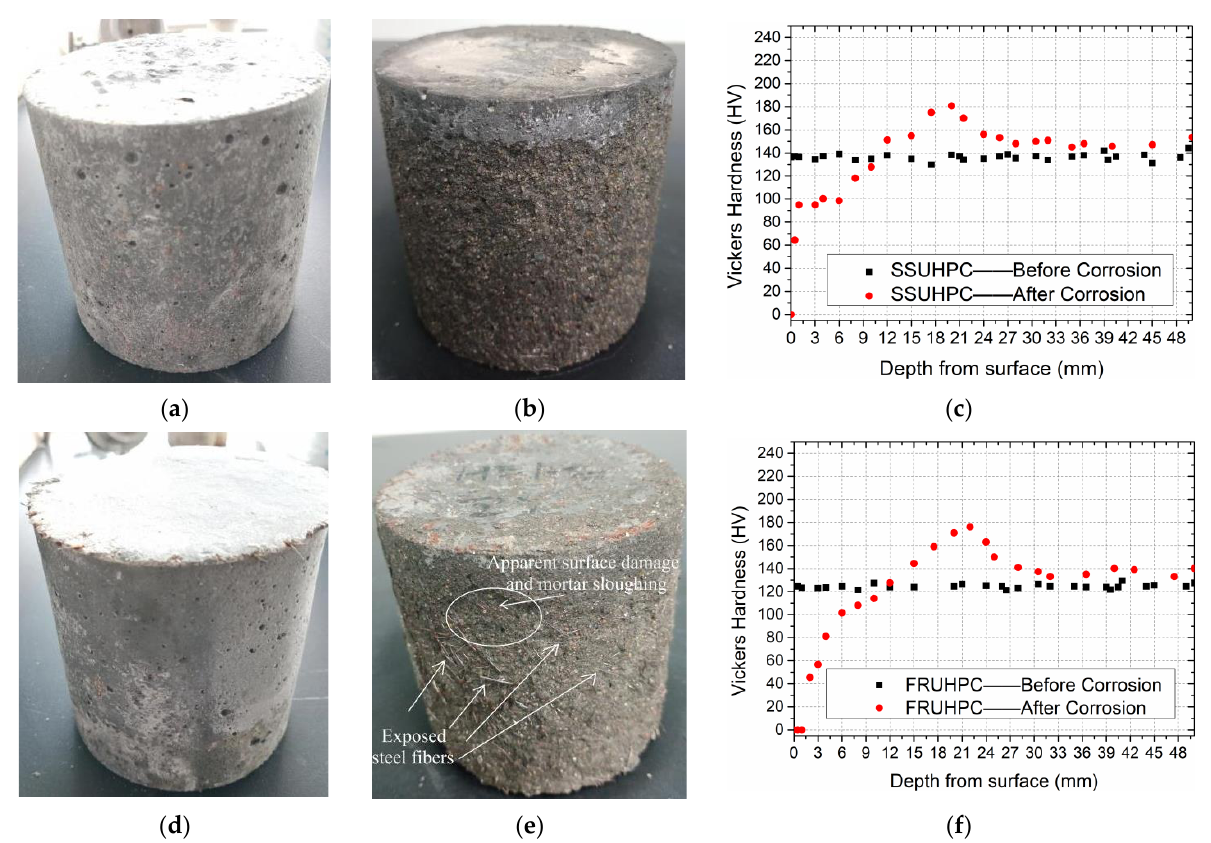
Figure 8. Comparison of SSUHPC and FEUHPC before and after sulfate erosion. ( a ) SSUHPC before sulfate erosion; ( b ) SSUHPC after sulfate erosion; ( c ) Change of Vickers hardness; ( d ) FRUHPC before sulfate erosion; ( e ) FRUHPC after sulfate erosion; ( f ) Change of Vickers hardness.